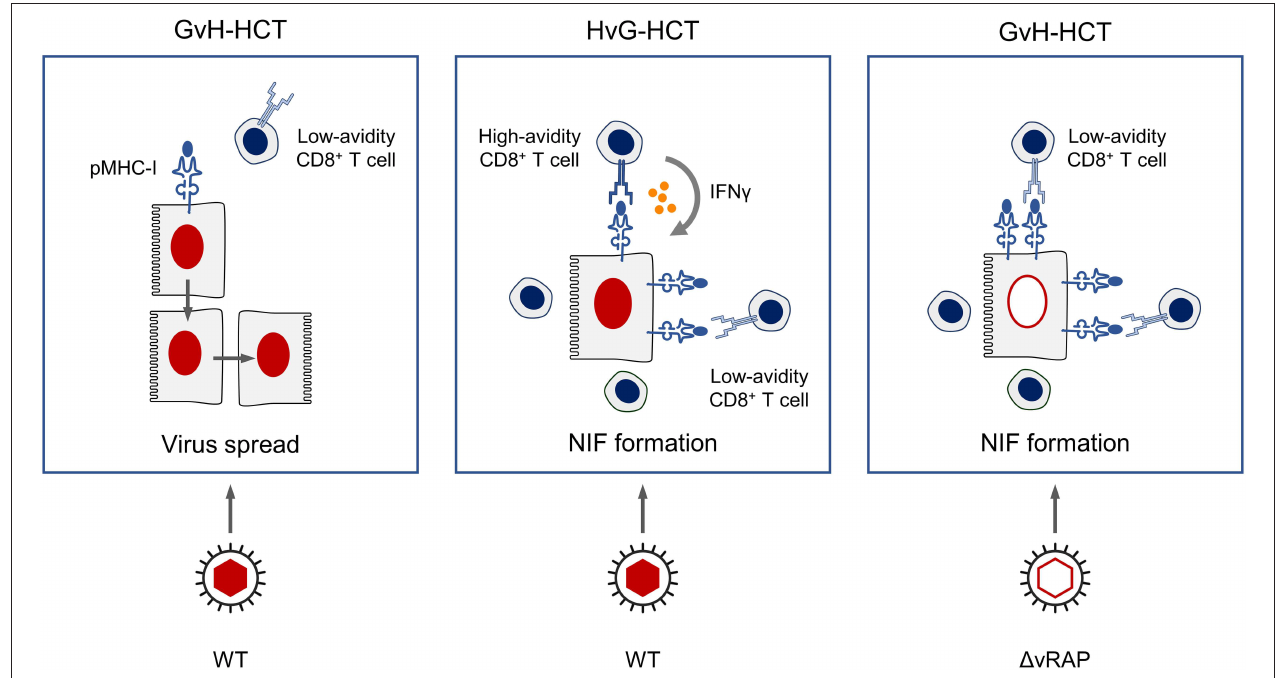
FIGURE 11 | Graphical